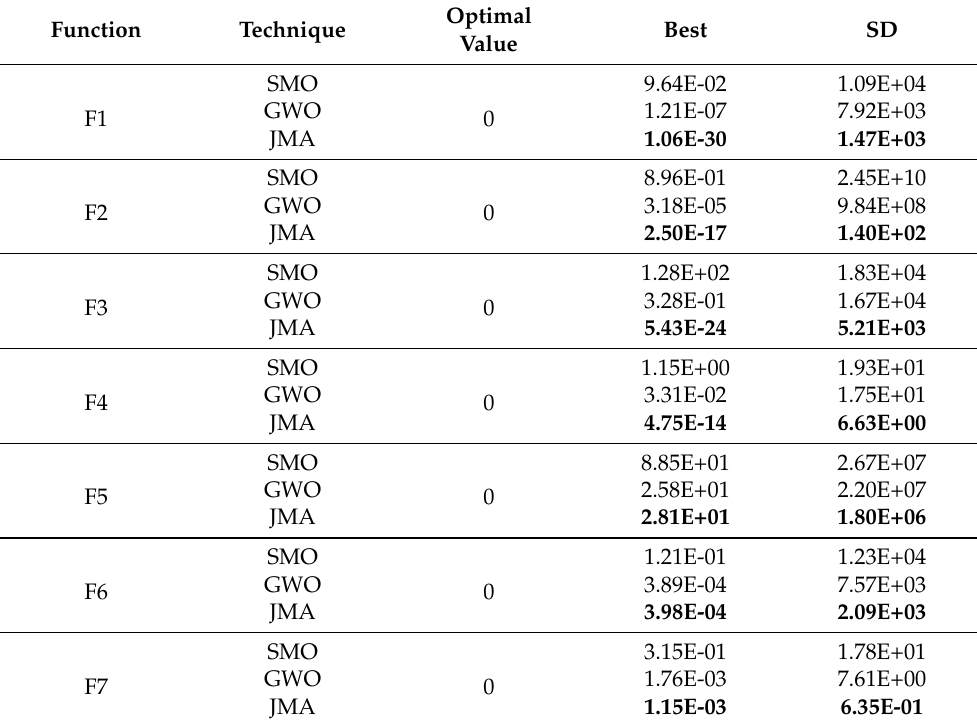
Table 3. Experimental results of unimodal benchmark